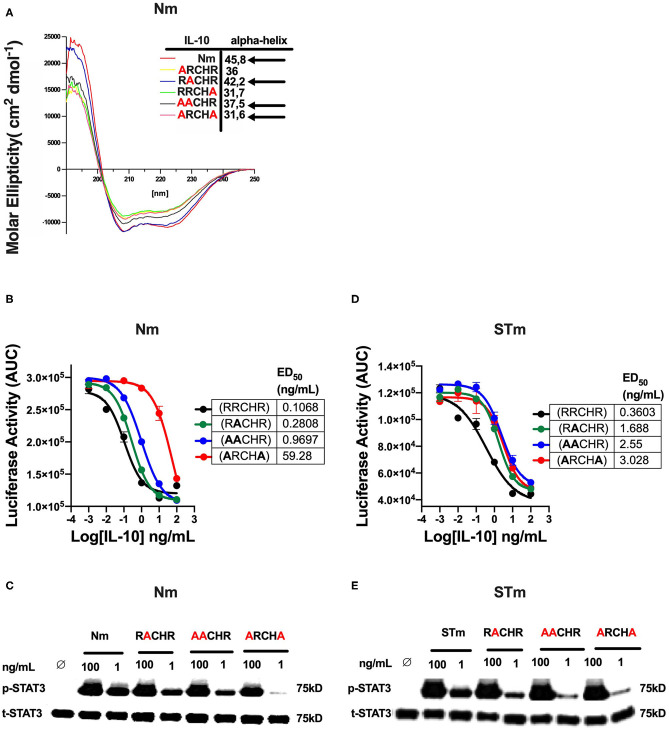
The effect of amino acid substitution at the RRCHR region of mouse IL-10 on biological activities. (A) The secondary structure of IL-10 mutants by CD spectroscopy adopted from unpublished data (36). (B) The ED50 of natural IL-10 was calculated as flow: NmRRCHR (un-mutant) (black line) (0.1 ng/mL), NmRACHR (green line) (0.28 ng/mL), NmAACHR (blue line) (0.96 ng/mL), and NmARCHA (red line) (59.28 ng/mL). (C) The activation of cellular signaling (p-STAT3) determines by western blot after lysate from spleen cells of the C57BL/6 mouse treated Nm mutants and un-mutant (control) in dose-response and using the total STAT3 as an internal control. (D) The ED50 of stable IL-10 was calculated as flow: STmRRCHR (un-mutant) (black line) (0.36 ng/mL), STmRACHR (green line) (1.6 ng/mL), STmAACHR (blue line) (2.55 ng/mL), and STARCHA (red line) (3.02 ng/mL). (E) The activation p-STAT3 determines by western blot from spleen cells lysate of the C57BL/6 mouse treated STm mutants and un-mutant (control) in dose-response and using the total STAT3 as an internal control. The data represented as AUC (Area Under the Curve). All data are representative of two independent experiments, with triplicate cultures per experiment (N = 2, n = 3), and bars represent standard error of the mean.